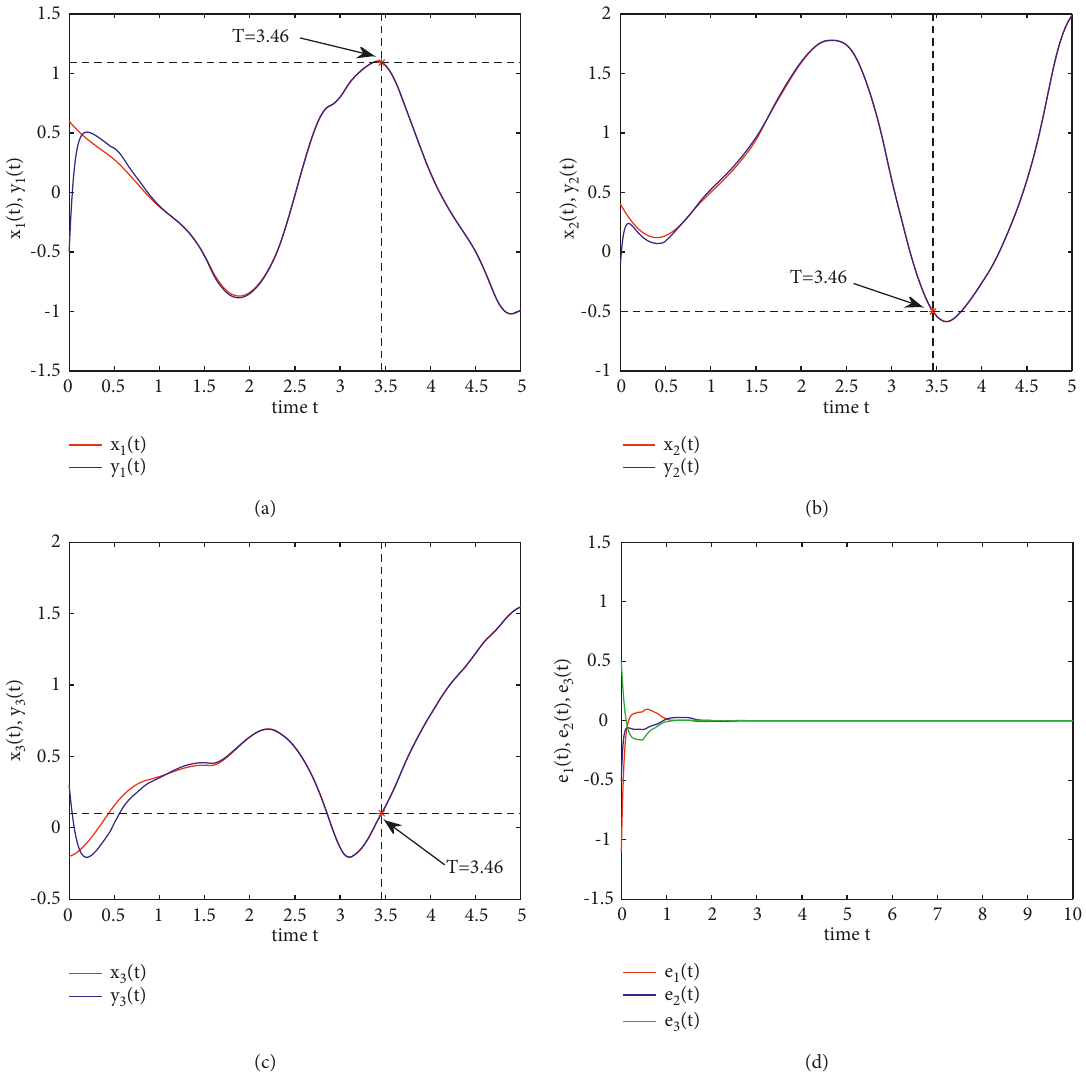
Figure 8: (a) Trajectories of x ( t ) and y ( t ) for drive-response system under the controller (58); (b) trajectories of x 1 1 response system under the controller (58); (c) trajectories of x ( t ) ,e ( t ) , and e ( t ) for drive-response system under the controller trajectories of e 1 2 3